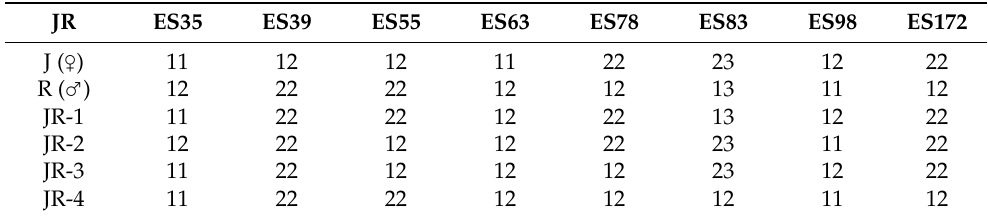
Table 4. Fingerprints of 62 true hybrids from ‘Jinhuang’ × ‘Renong No.1’ cross using alleles detected with eight SSR primers.